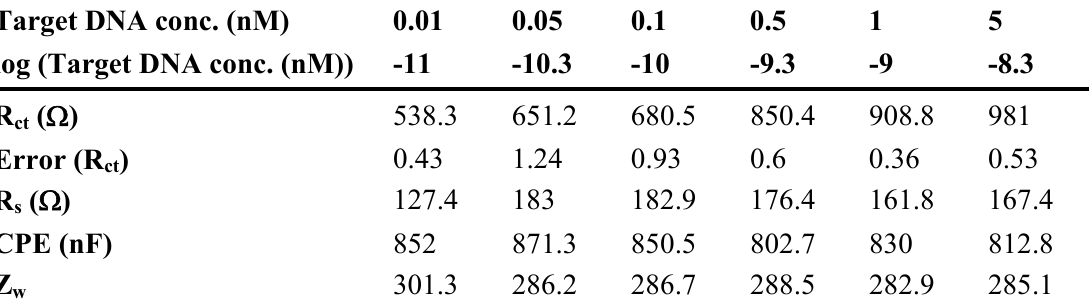
Table 3. EIS parameters of GCE/PPI-AuNP/dsDNA obtained from Figure 7a. Target DNA conc.